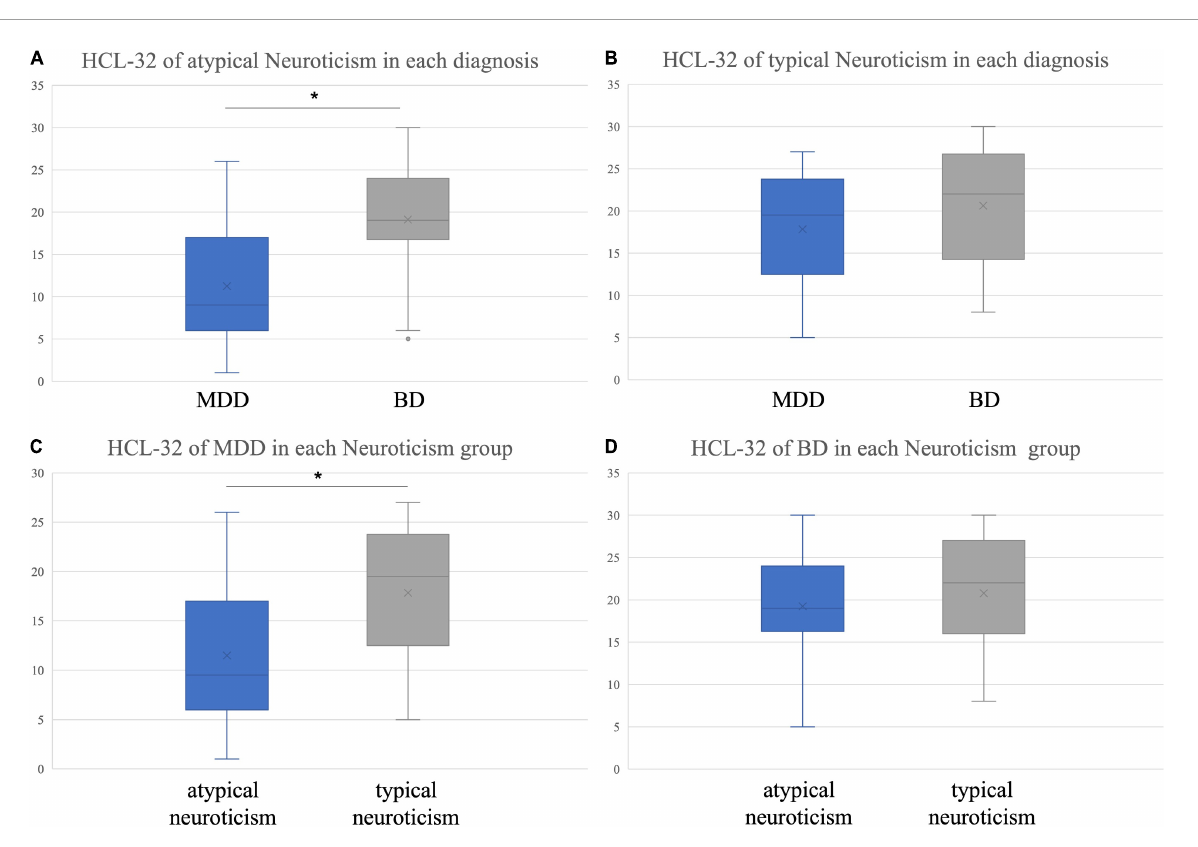
FIGURE2 Hypomania checklist-32 score of different personality traits in each diagnosis. (A) Differences in HCL-32 scores between BD and MDD patients in the atypical neuroticism group; (B) Differences in HCL-32 scores between BD and MDD patients in the typical neuroticism group; (C) Differences in HCL-32 scores between atypical and typical neuroticism in MDD patients; (D) Differences in HCL-32 scores between atypical and typical neuroticism in BD patients. * p < 0.05 Bonferroni